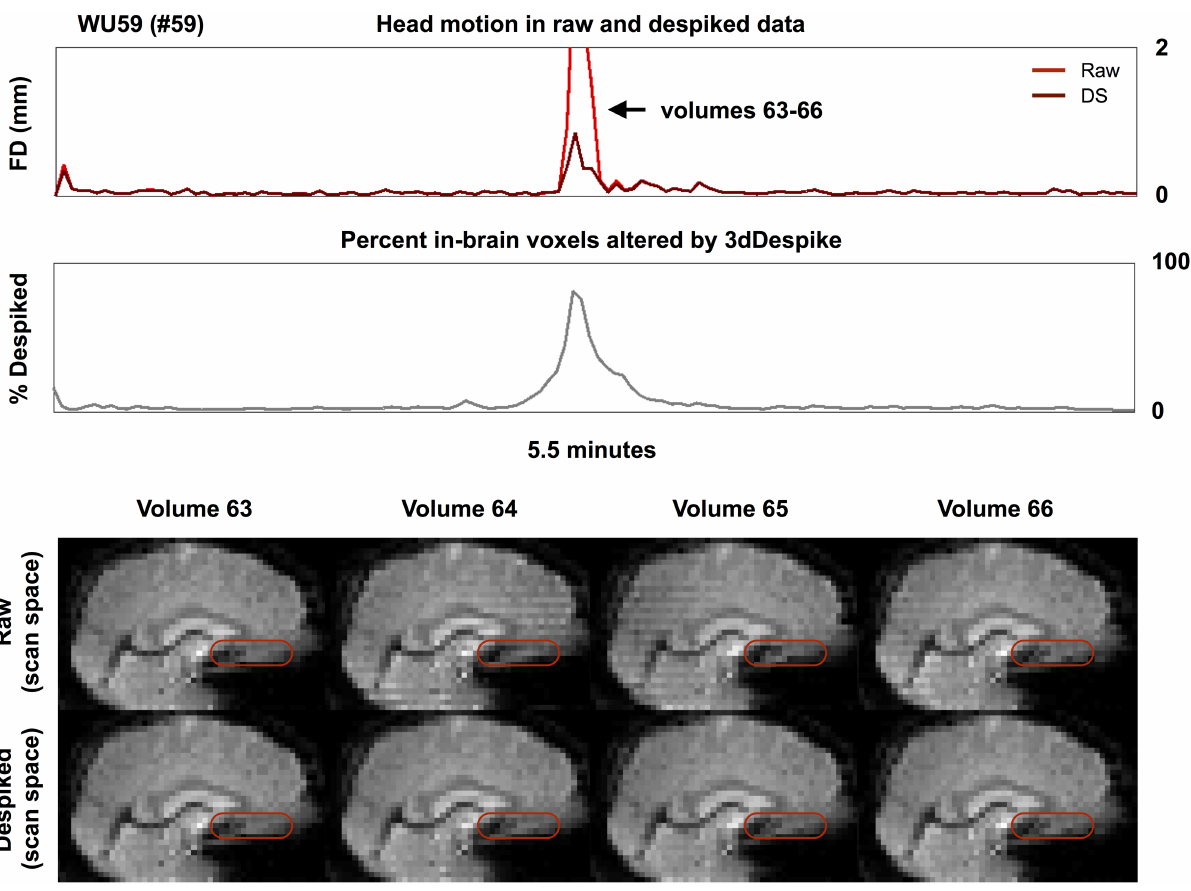
Fig 2. Despiking alters brain position. For a subject of the WU cohort, motion estimates and despiketraces are shown at top. Slices of the raw and despikedimage are shown spanning a large motion. There is a positive pitch (nose up) rotation at volumes 64 and 65 in the raw data. This motion is attenuatedin the